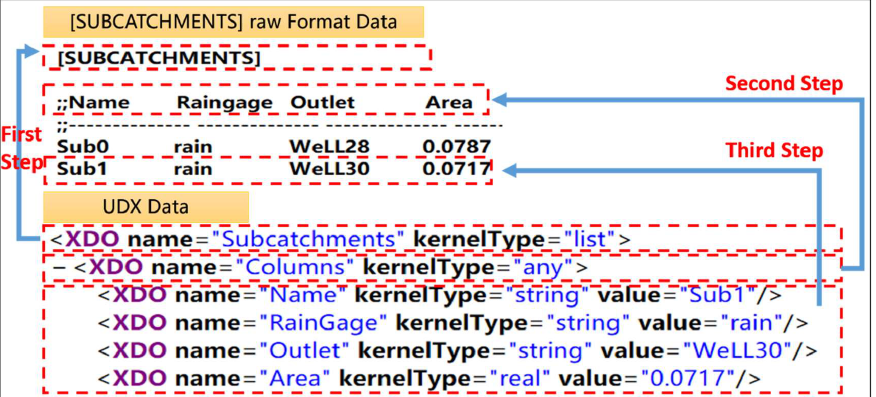
Figure 10. Convert UDX data to the raw format data of SWMM.